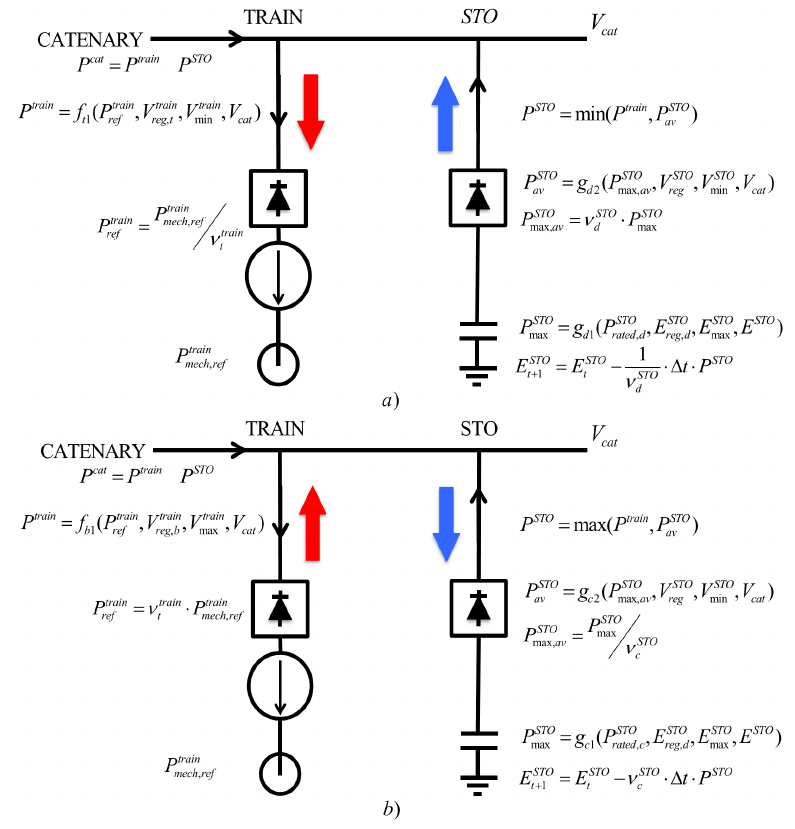
Figure 1. Equivalent mathematical model of the train plus storage system ( a ) Traction mode. ( b ) Braking